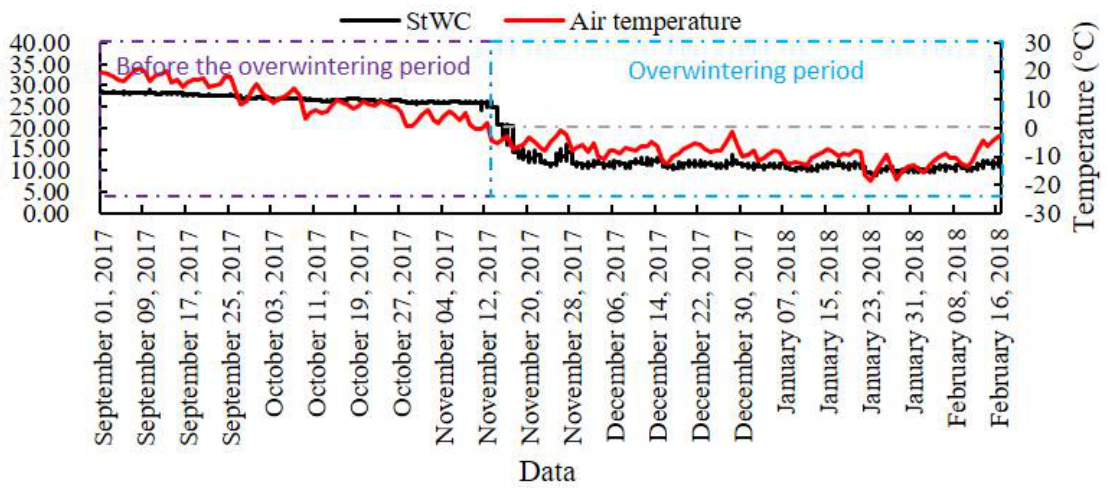
Figure 9. StWC changes in Pinus tabuliformis Carriere during the overwintering period when experiencing freeze-thaw stress.